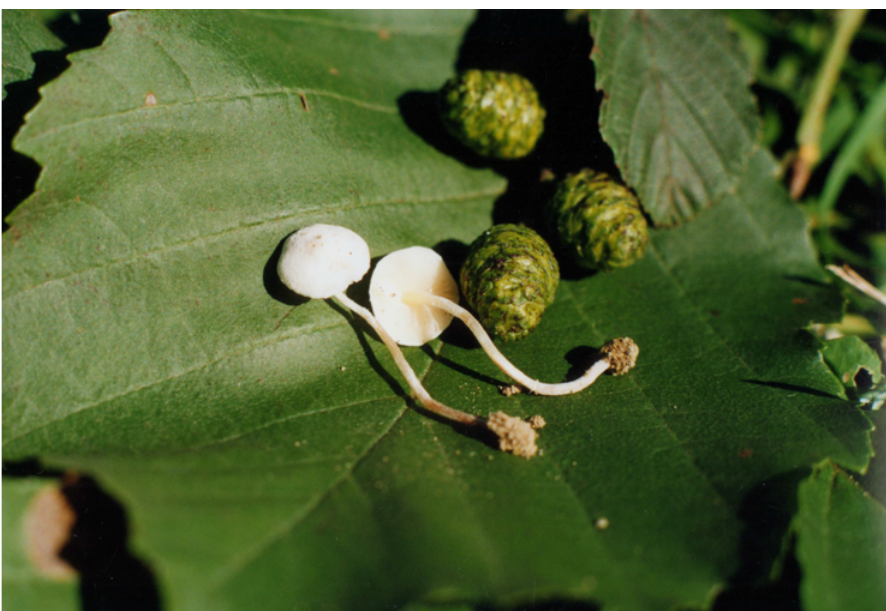
Fig. 2. Cystolepiota seminuda fairly common humicolous fungus growing in carr forests (Phot. A. Bujakiewicz).